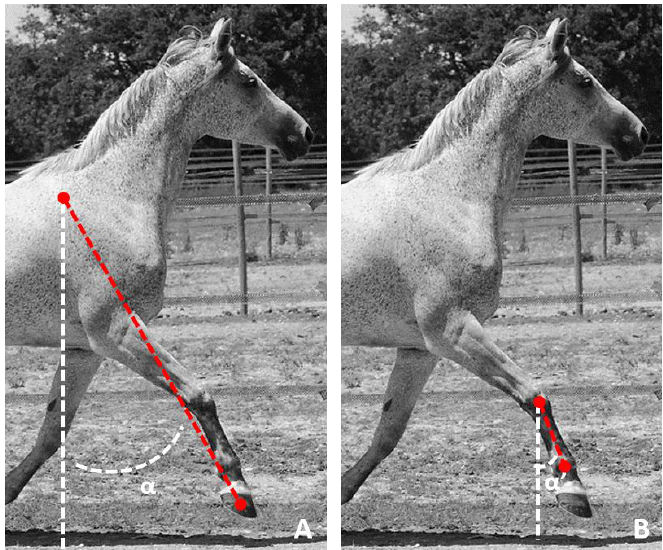
Figure 1. Representation of ( A ) the angle α of protraction of the whole limb measured from the orientation of the segment connecting the tuber spinae scapulae and the hoof with respect to the vertical and ( B ) of the angle α’ of protraction measured from the orientation of the canon bone (third metacarpal bone) relative to the vertical.